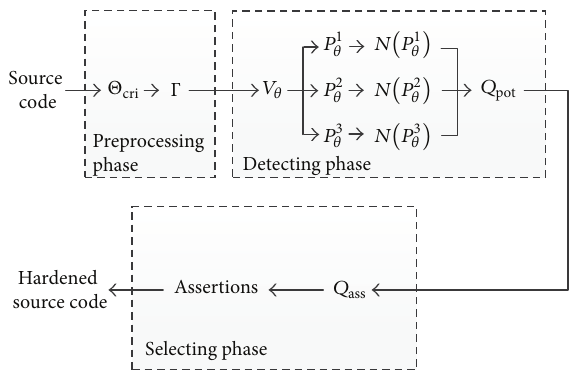
Figure 2: The workflow of